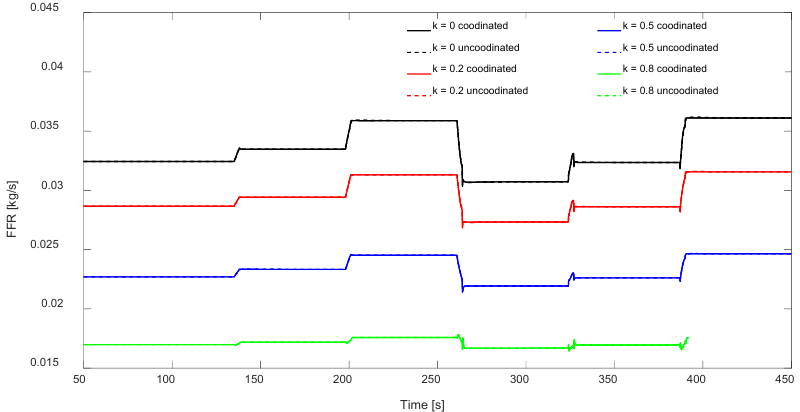
Figure 13. Effect of k and coordination on fuel flow rate.